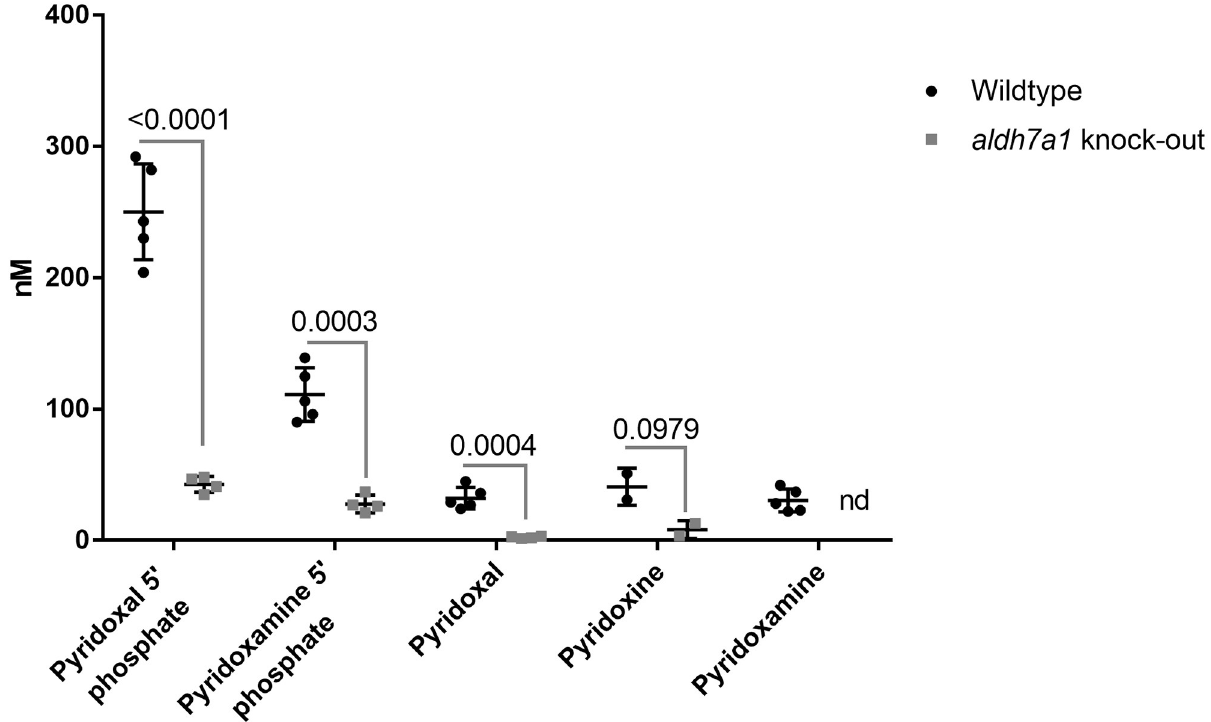
Fig 2. Decreased levels of vitamin B6 vitamers in aldh7a1 knock-out 11 dpf embryos relative to age-matched wildtype control embryos. Vitamin B6 vitamers levels are reduced in aldh7a1 homozygous knock-out embryos relative to the wildtype. It is shown in a scatterplot of quantification of the levels of vitamin B6 vitamers in aldh7a1 homozygous knock-out zebrafish relative to the wildtype as measured by LC-MS. The graph demonstrates decreased levels of vitamin B6 vitamers in aldh7a1 knock-out 11 dpf embryos (aldh7a1 knock-out, grey squares) relative to the age-matched wildtype control embryos (Wildtype, black circles). Each dot represents metabolite data collected from 20 embryos. For a single data point of homozygous aldh7a1 knock-out zebrafish, only 16 embryos were available, so that data point was excluded from the analysis. nd, not detectable–the levels of metabolites could not be measured. p values were calculated by unpaired student t-test for multiple measurements followed by Holm-Sadak correction for multiple analysis. Error bars, SD.